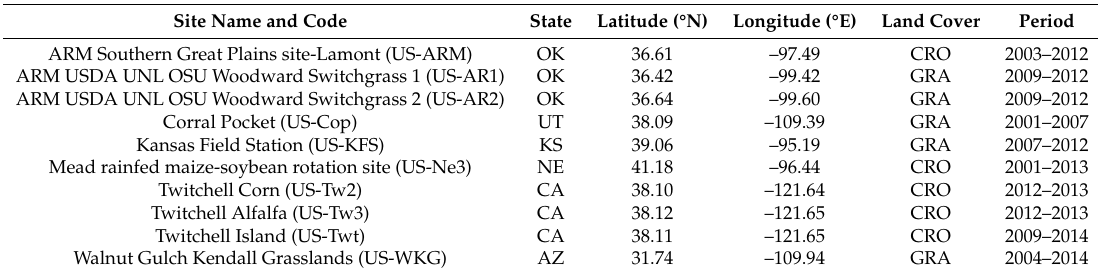
Table 1. Basic information regarding the FLUXNET sites used in this study. GRA denotes grass and CRO denotes